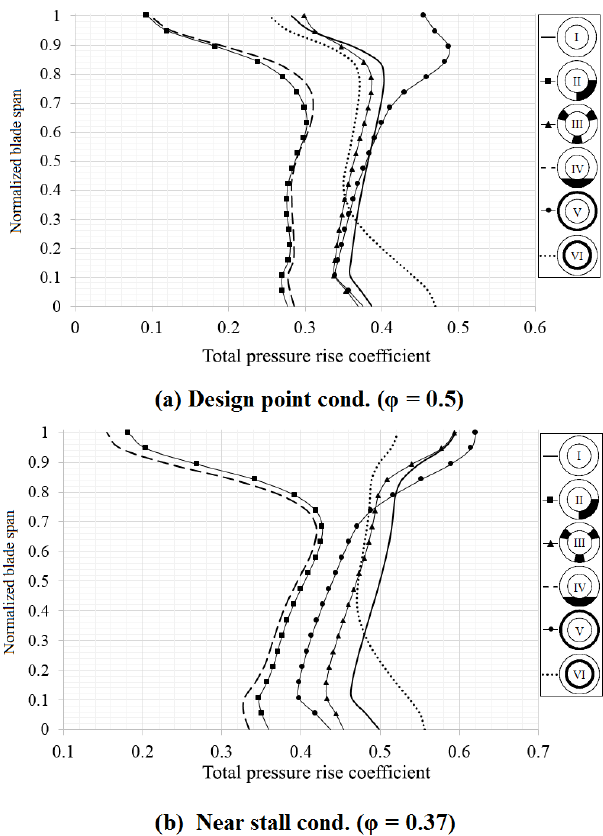
Figure 13. Spanwise distributions of total pressure rise coefficient for different